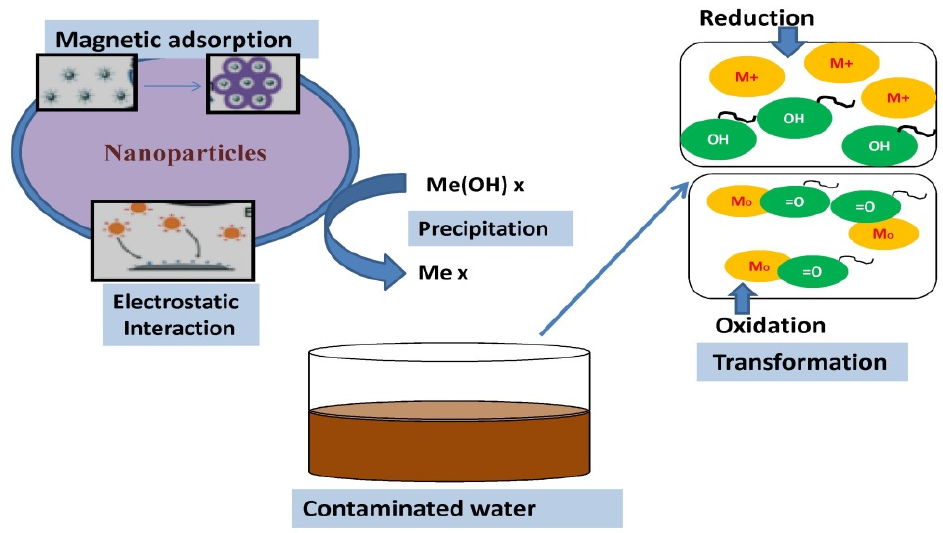
Figure 3. Key processes of the remediation of pollutants in contaminated water by nanoparticles.